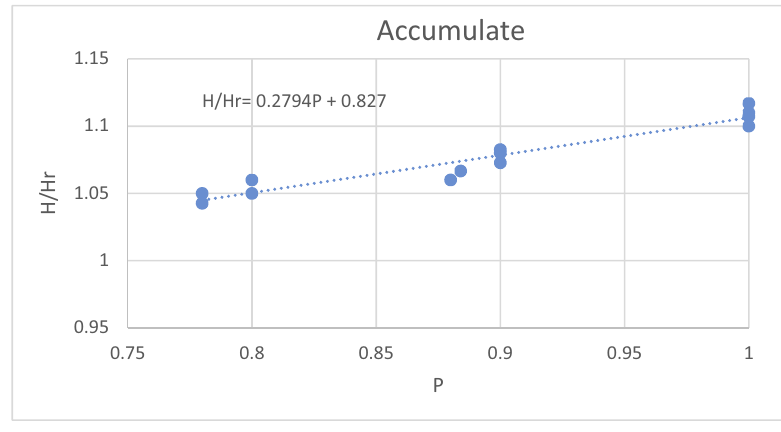
Figure 15: The relation of accumulated driftwood trap index ( p ) to ( H/Hr ) for all cases ( A - L ) .